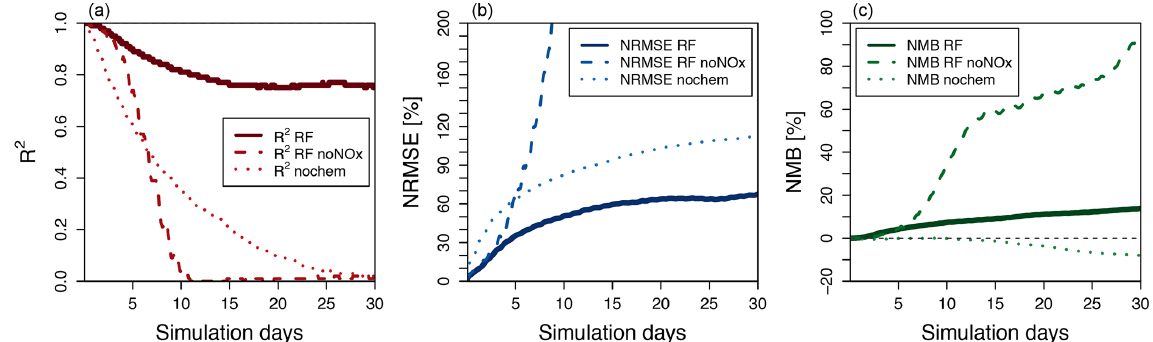
Figure 6. Thirty-day evolution of R 2 (a) , NRMSE (b) and NMB (c) for three different model simulations of O 3 run for July 2014 compared to the full GEOS-Chem simulation. The solid line represents the standard random forest (RF) simulation using the family prediction of NO x . The dashed line uses RF predictors for NO and NO 2 individually (this simulation becomes unstable after 23 days). The dotted line represents a simulation with no chemistry. The grey line in (c) indicates a 0 value.